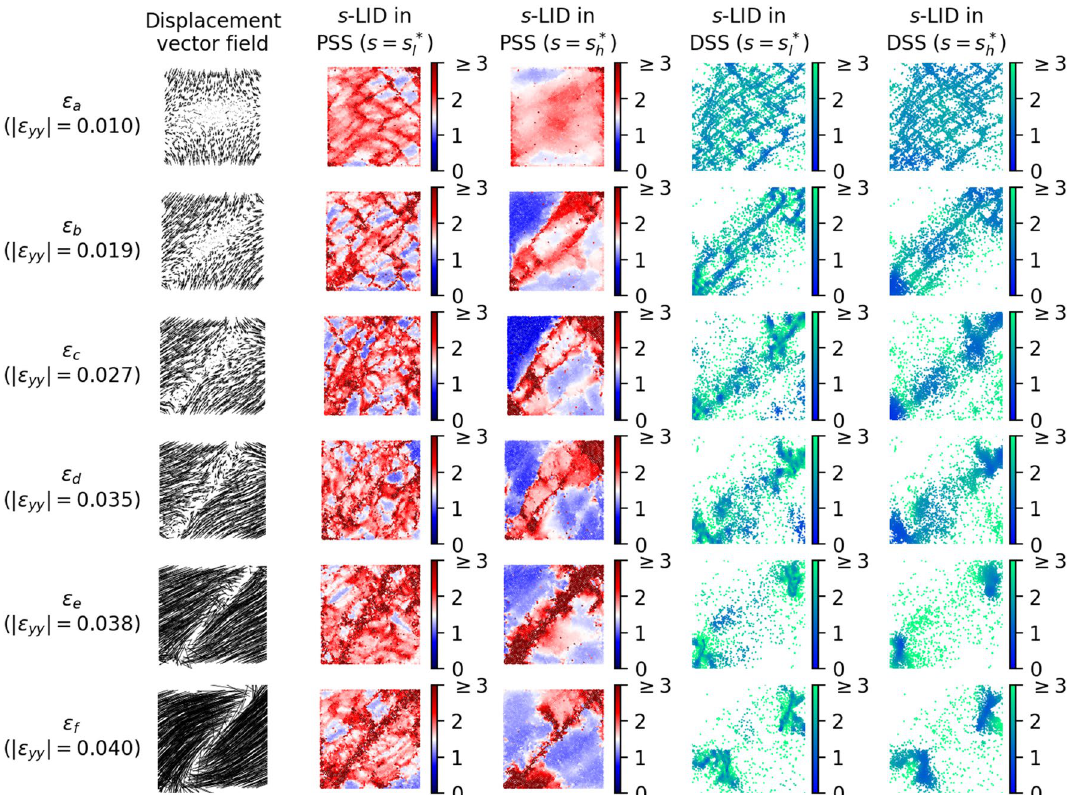
Figure 4. Visualization of displacement vector field, s -LID values of particles in DSS ( x and y axes are movement in horizontal and vertical directions) and PSS ( x and y axes are spatial coordinates) at different stages of the loading history for sample 5K. Under low strain, s -LID ( s = 200 ) highlights particles in the local sparse region in DSS with high score, which constitute microbands when mapping back to PSS. In contrast, particles in the shearbands are detected as global outliers in the DSS, as marked by higher s -LID scores with s = 1600 .